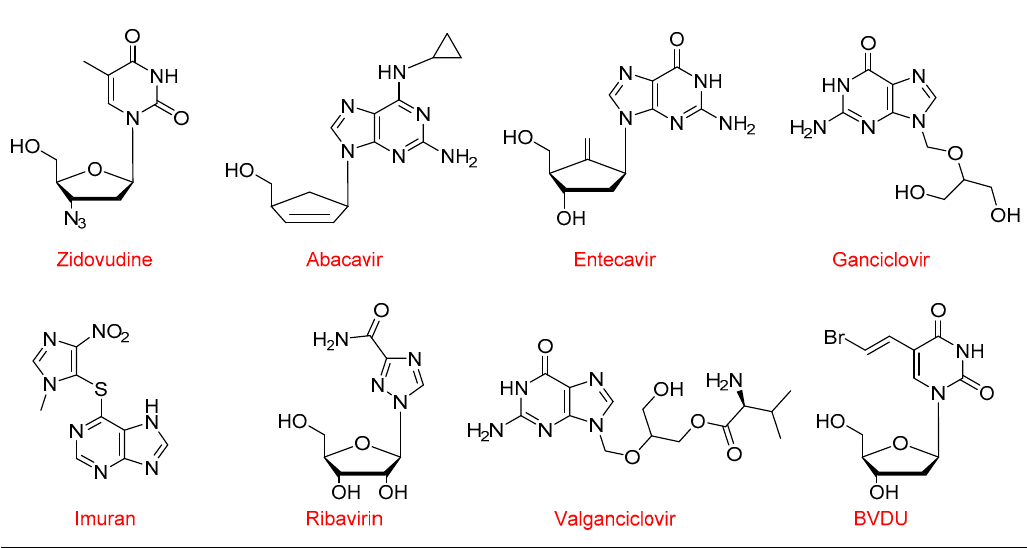
Figure 1. List of Food Drug Administration(FDA) approved modified nucleoside drug molecules.